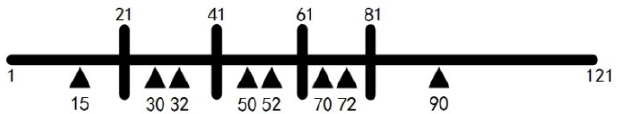
Figure 3. Four-span four-disc rotor supported by oil-journal bearings (h4.4).